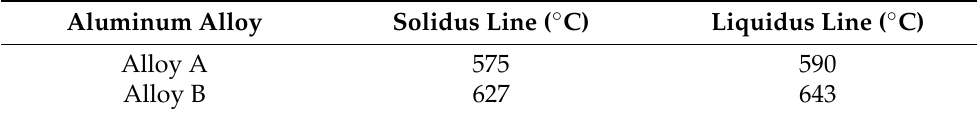
Figure 16. Surface of clad strips for which overlay strips were different aluminum alloys. The solidification length of the overlay strip in ( a ) was 25 mm, and in ( b ) was 70 mm. The solidus and liquidus lines of Alloy A and Alloy B are shown in Table 2. Table 2. Solidus and liquidus lines of Alloys A and B in Figure